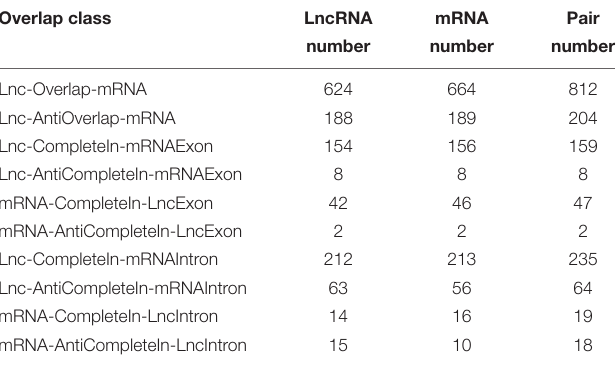
TABLE 1 | The classification of overlap.